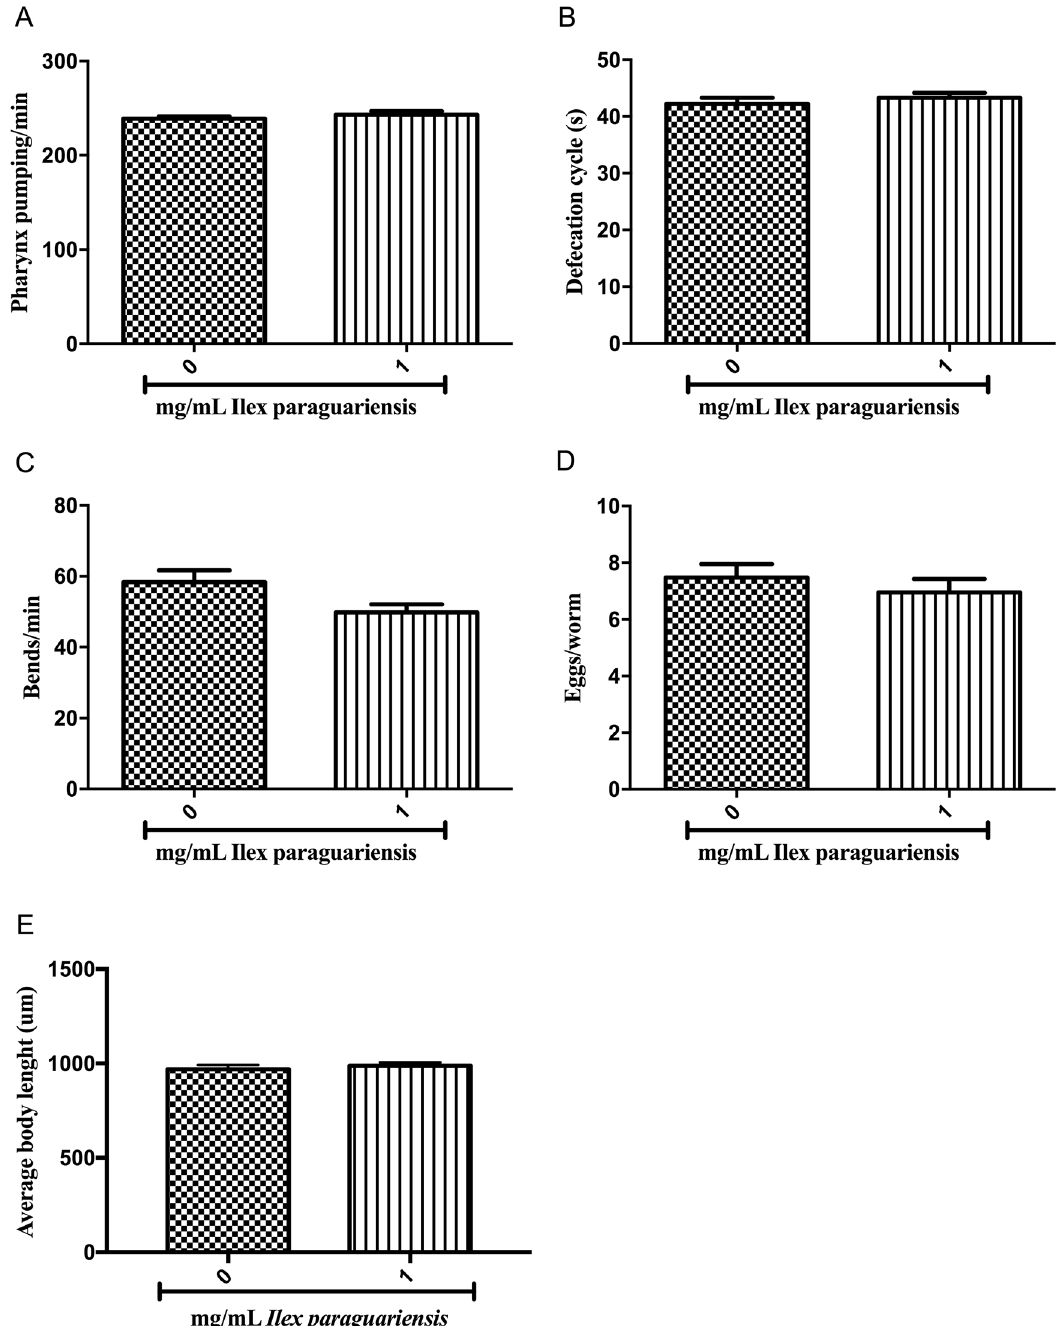
Fig 3. Caenorhabditiselegans wild-type behavior following Ilexparaguariensis treatment. Effect of I . paraguariensis on (A) pharyngeal pumping rate, (B) defecation cycle length, (C) body bends in wild-type young adults, (D) egg production and (E) body length in wild-type young-adults. No statistically significant difference was found by Student’s t -test (mean, SEM, n = 30 worms per group). The experiments were performed in triplicate.